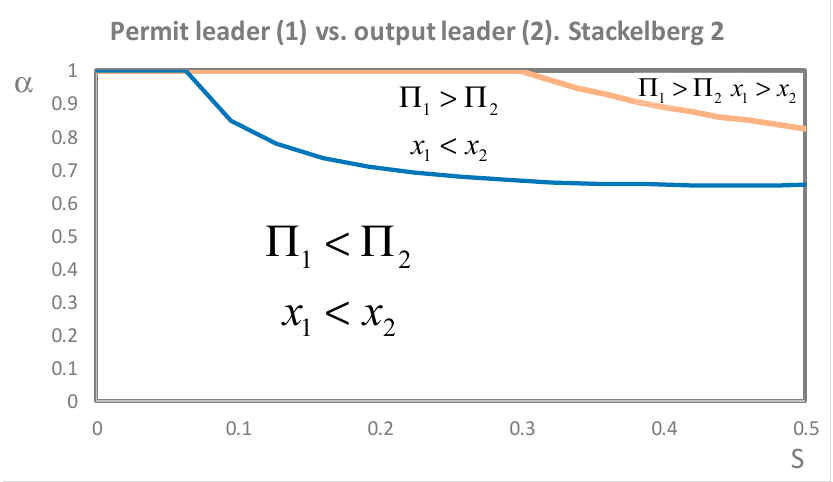
Figure 2. Output and profit comparison (firm 1 vs. firm 2) in model Stackelberg 2 Figure2. Output and profit comparison (firm 1 vs. firm 2) in model Stackelberg 2 (Propositions 5 and (Propositions 5 and 6).